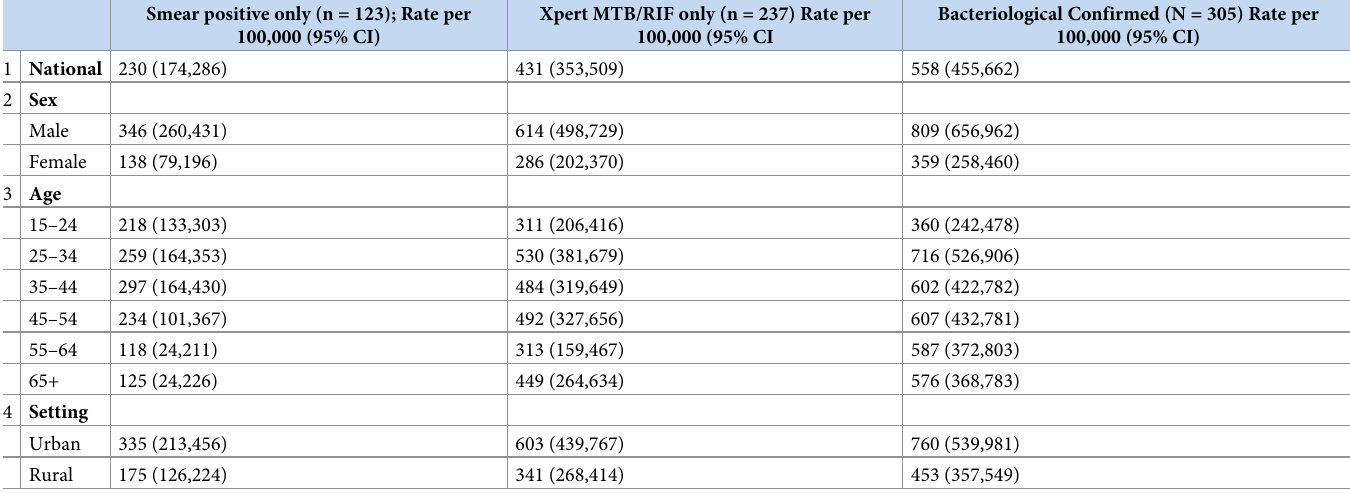
Table 3. Overview of weighted pulmonary TB prevalence adults aged 15 years and above per 100,000 population in Kenya. Smear positive only (n = 123); Rate per 100,000 (95%